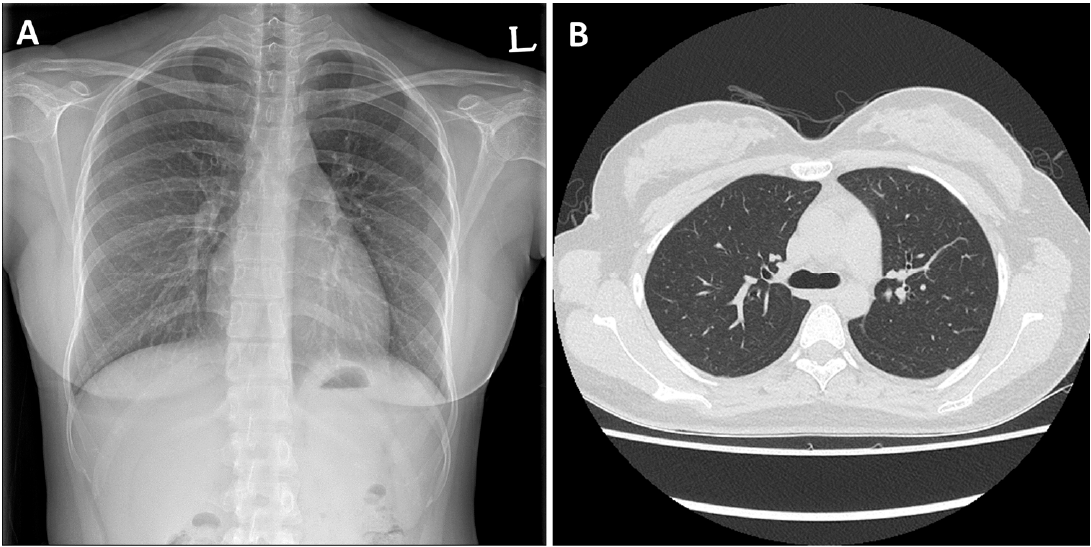
Figure 2. ( A ) Chest radiograph and ( B ) chest computed tomography showing improvement of bilateral infiltration and multiple small nodular ground-glass opacities after treatment.